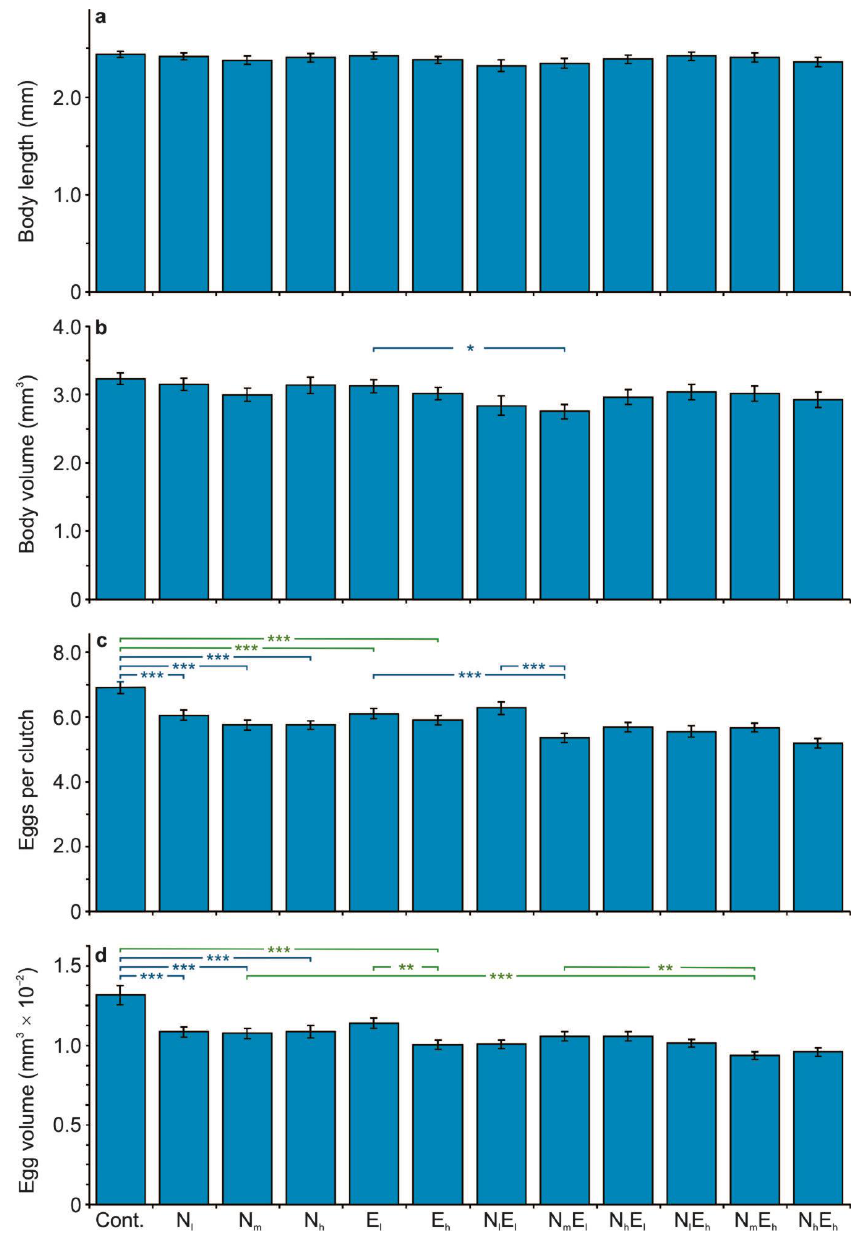
Figure 1. Mean values (± 1 SE) of: ( a ) body length, ( b ) body volume, ( c ) clutch size (the number of eggs per ovigerous female), and ( d ) egg volume of 5-day-old D. magna from the control variant (Cont.) and from variants of a single or combined low, medium, and high density of polystyrene NPs (N l = 10 3 , N m = 10 6 , and N h = 10 9 particles L − 1 , respectively) and low and high concentration of enrofloxacin (E l = 10 and E h = 100 ng L − 1 , respectively). Statistical significance is accepted at * p < 0.05, ** p < 0.005, or *** p < 0.0005. The NPs effect is marked on blue, and the enrofloxacin effect on green.